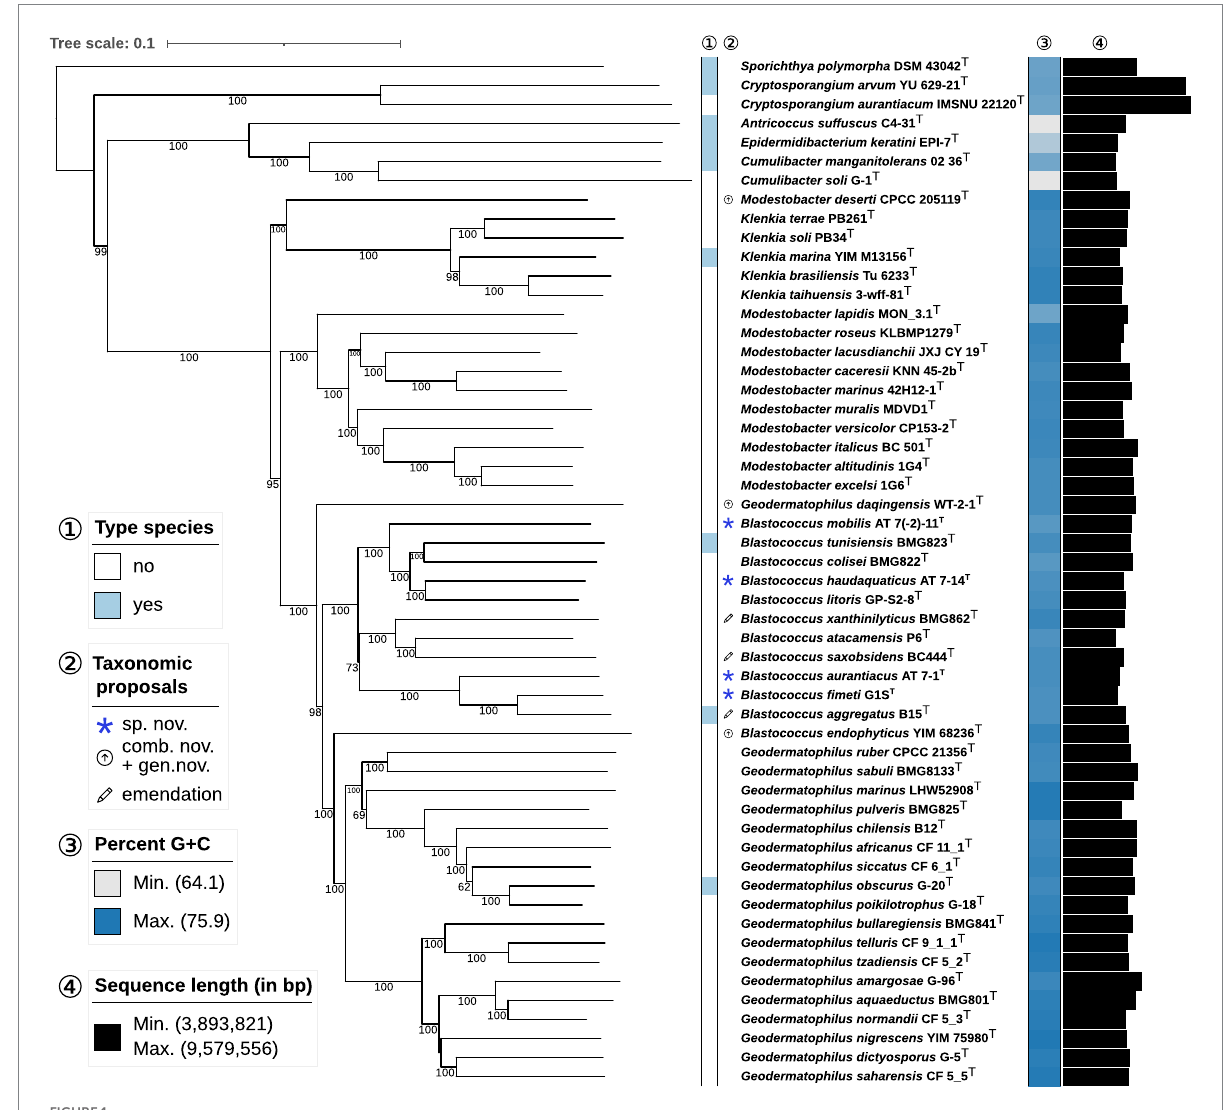
FIGURE 1 Phylogenomic tree inferred with GBDP. The tree was inferred with FastME from GBDP distances calculated from whole proteomes. The numbers above branches are GBDP pseudo-bootstrap support values from 100 replications. Tip colours indicate genome sizes and the exact G + C content as calculated from the genome sequences (see the embedded legend for details). A., Antricoccus ; B., Blastococcus ; C., Cryptosporangium; G., Geodermatophilus; K., Klenkia; M., Modestobacter; S.,